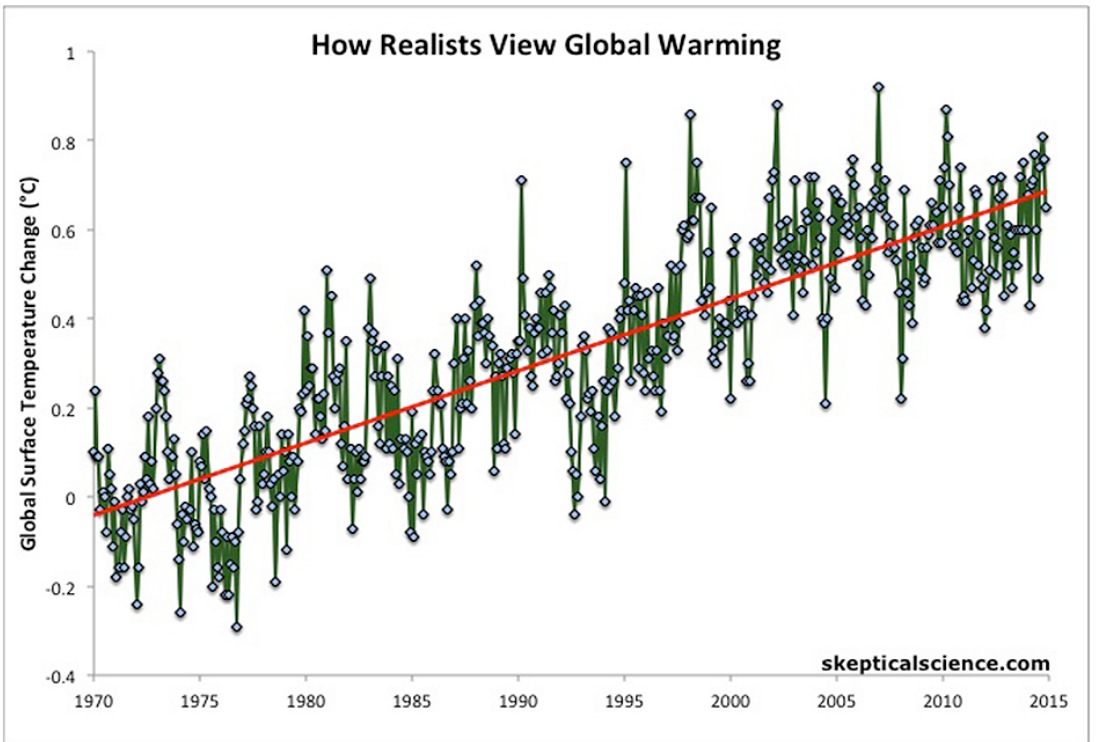
Figure 1. Global surface temperature change (from Skeptical Science